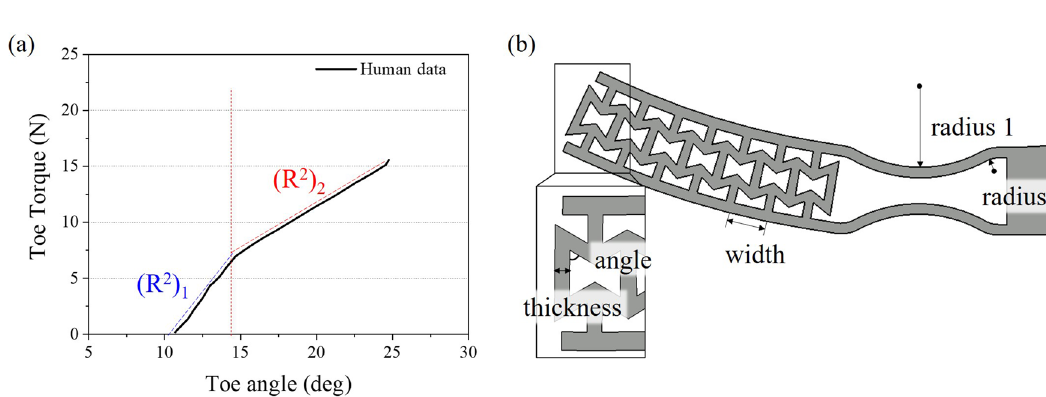
2 ) 2 ) 1 and ( R 2 ) among objective functions; ( b )